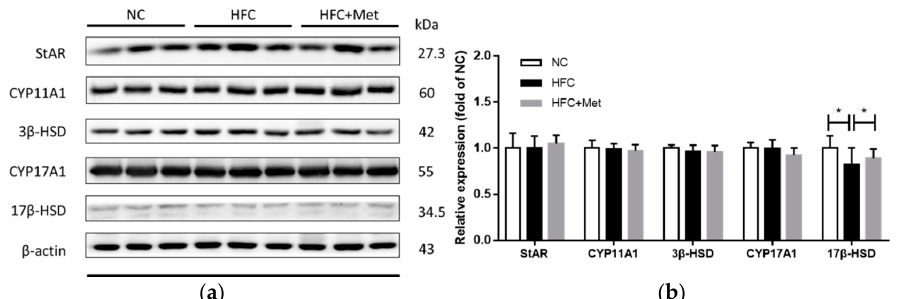
Figure 6. Effects of the high-fat and high-cholesterol diet and metformin supplementation on Figure testosterone biosynthesis regulators (StAR, CYP11A1, 3 β -HSD, CYP17A1 and 17 β -HSD) in the male mice: ( a ) Protein expressions in each group were measured using western blot analysis, and β -actin